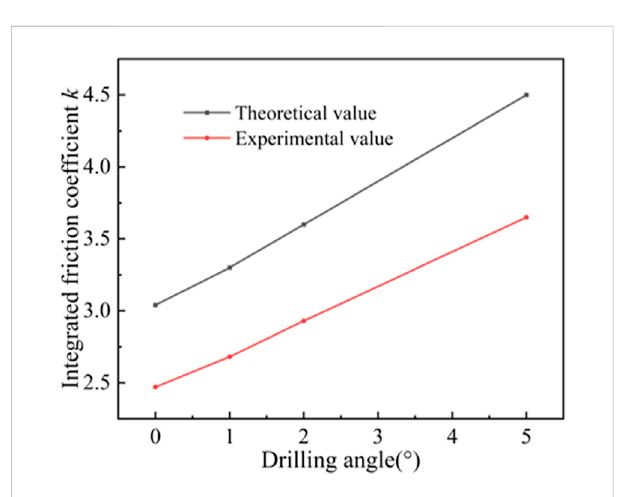
FIGURE 11 Variation pattern of k at different angles.